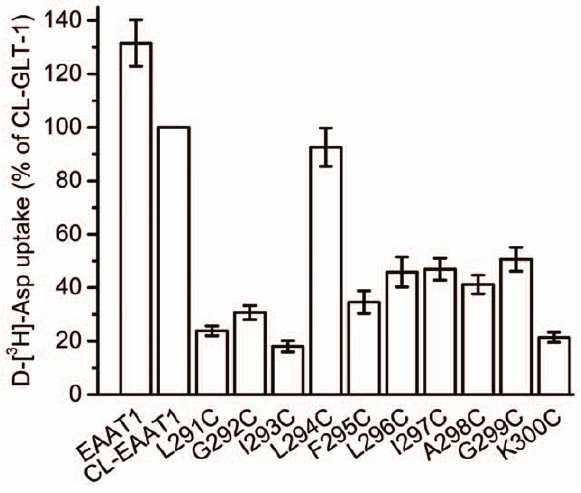
Figure 2. Transport activity of single cysteine mutants of TM5. The Cysteine-less EAAT1 and the TM5 mutants were expressed in HeLa cells. D-[ 3 H]-aspartate uptake was measured as described under ‘‘Materials and methods’’. Data are given as a percentage of Cysteine- less EAAT1 transport activity and are mean 6 S.E. of 3 to 4 experiments each performed in triplicates.